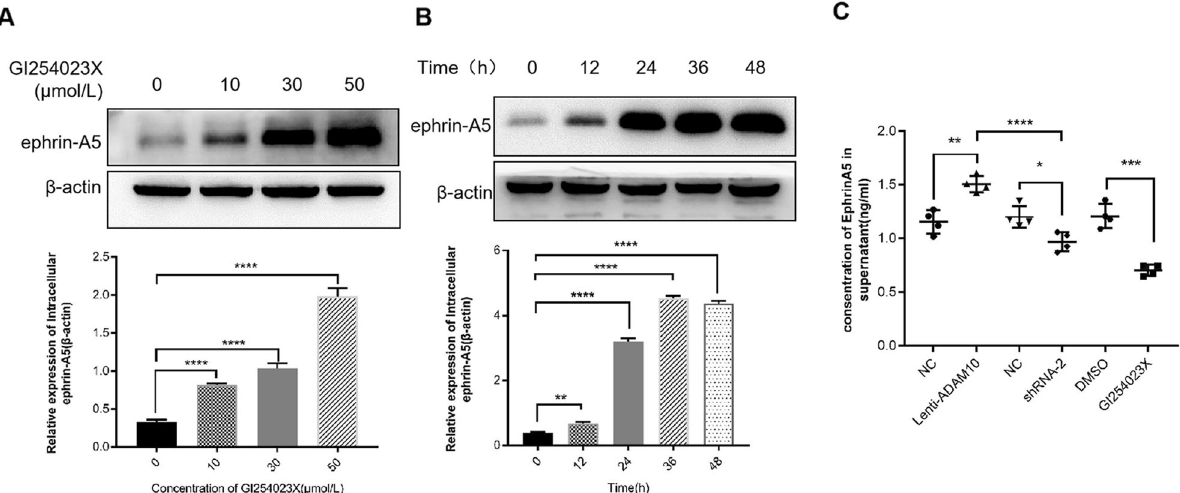
Fig. 4 ADAM10 induces the shedding of ephrin-A5. A Detection of intracellular ephrin-A5 protein content by Western blotting. GI254023X solutions of different concentrations were treated for 24 h, and the protein content of ephrin-A5 in the cells was detected, **** P < 0.0001. B After being treated with 50 μ mol/L GI254023X solution for different time, the content of ephrin-A5 protein in cells was detected. ** P < 0.01, **** P < 0.0001. C Detection of ephrin-A5 content in cell culture medium by ELISA, * P < 0.05, ** P < 0.01, *** P < 0.001, **** P <